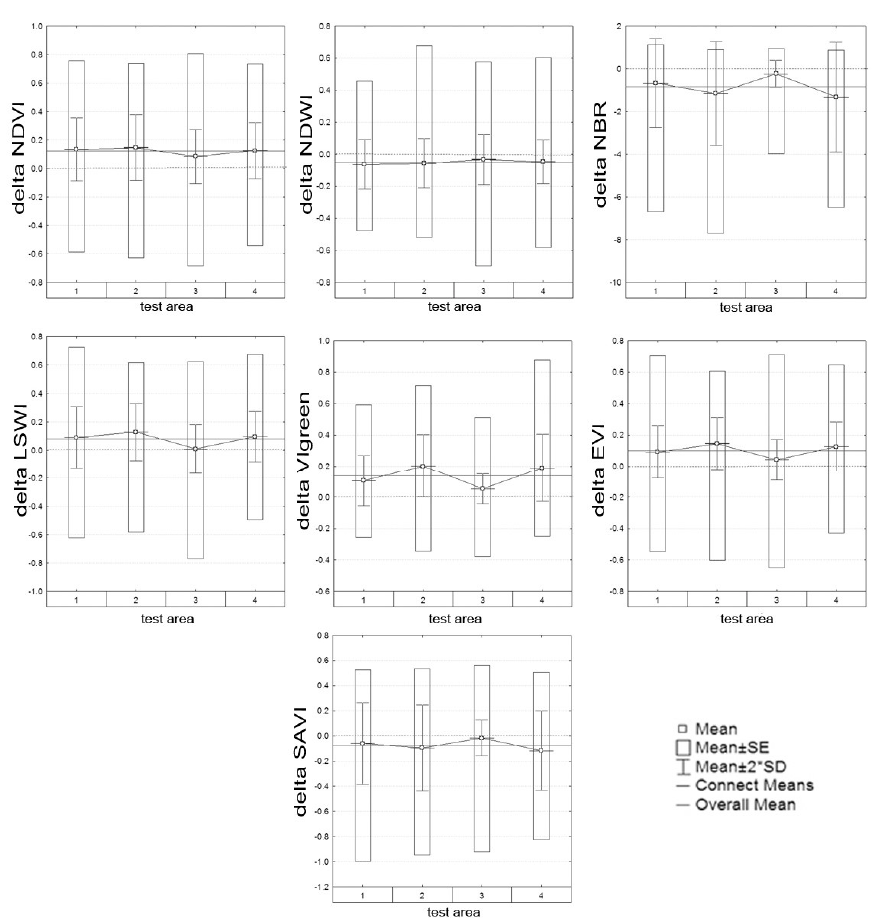
Figure 4. OLI and ETM+ based vegetation indices differences Box for each plot.